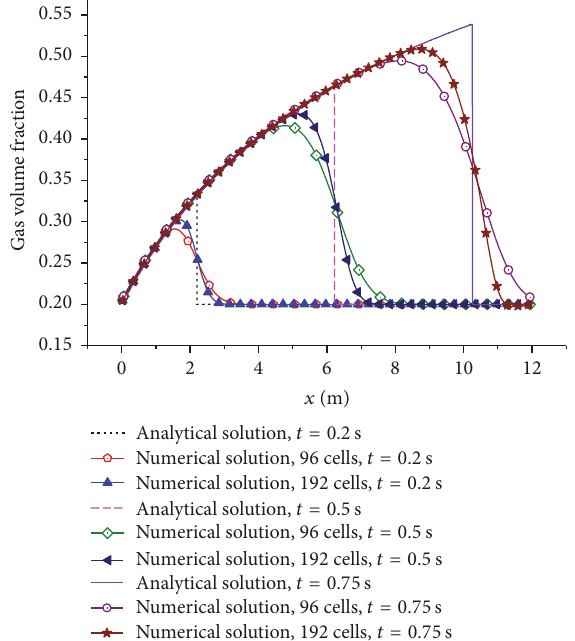
Figure 4: Gas volume fraction comparison between analytical solutions and numerical solutions from FOU scheme with 96 cells and 192 cells at time of 0.2, 0.5, and 0.75 seconds.